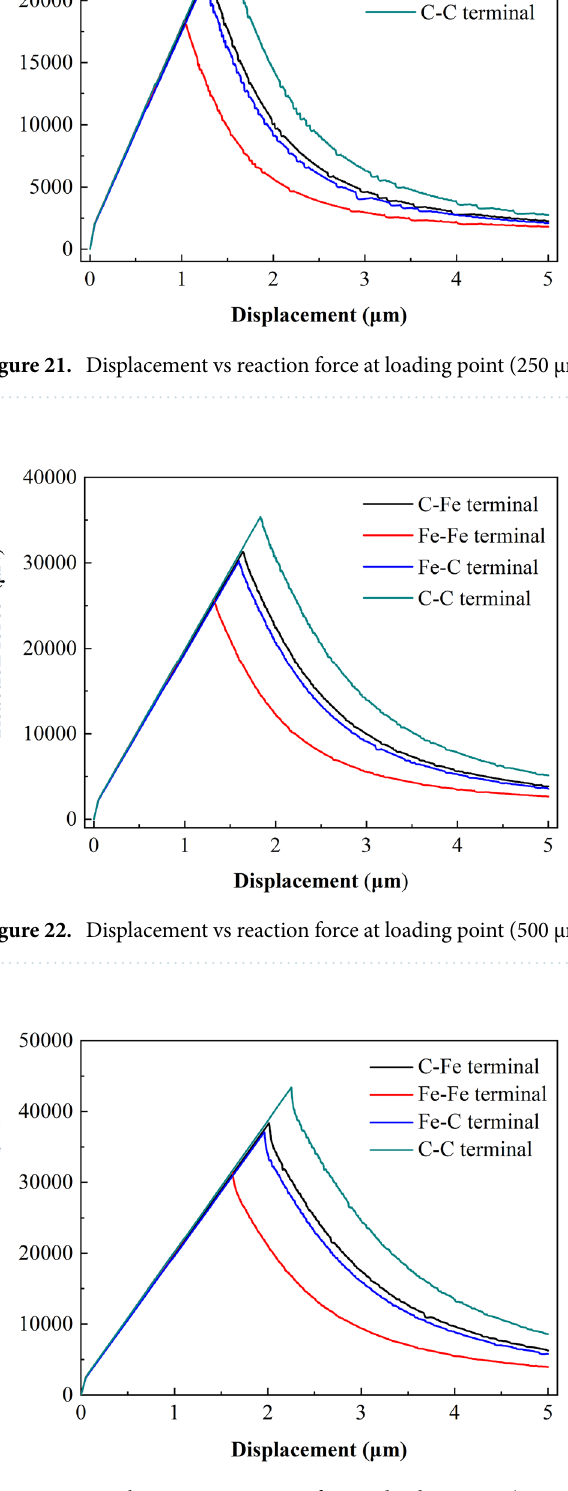
Figure 23. Displacement vs reaction force at loading point (750 μm × 720